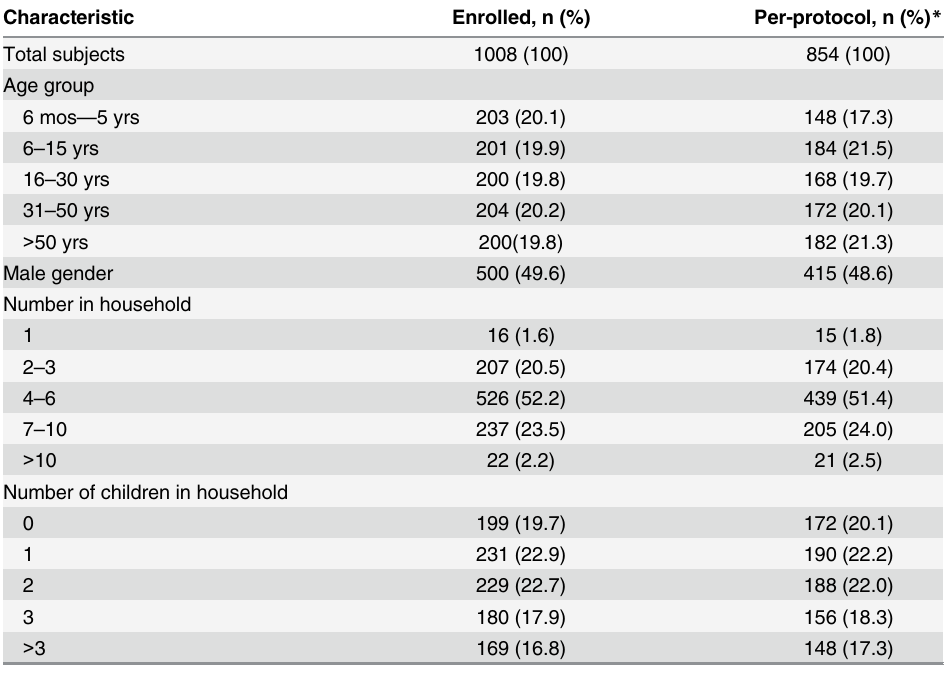
Table 1. Description of cohort